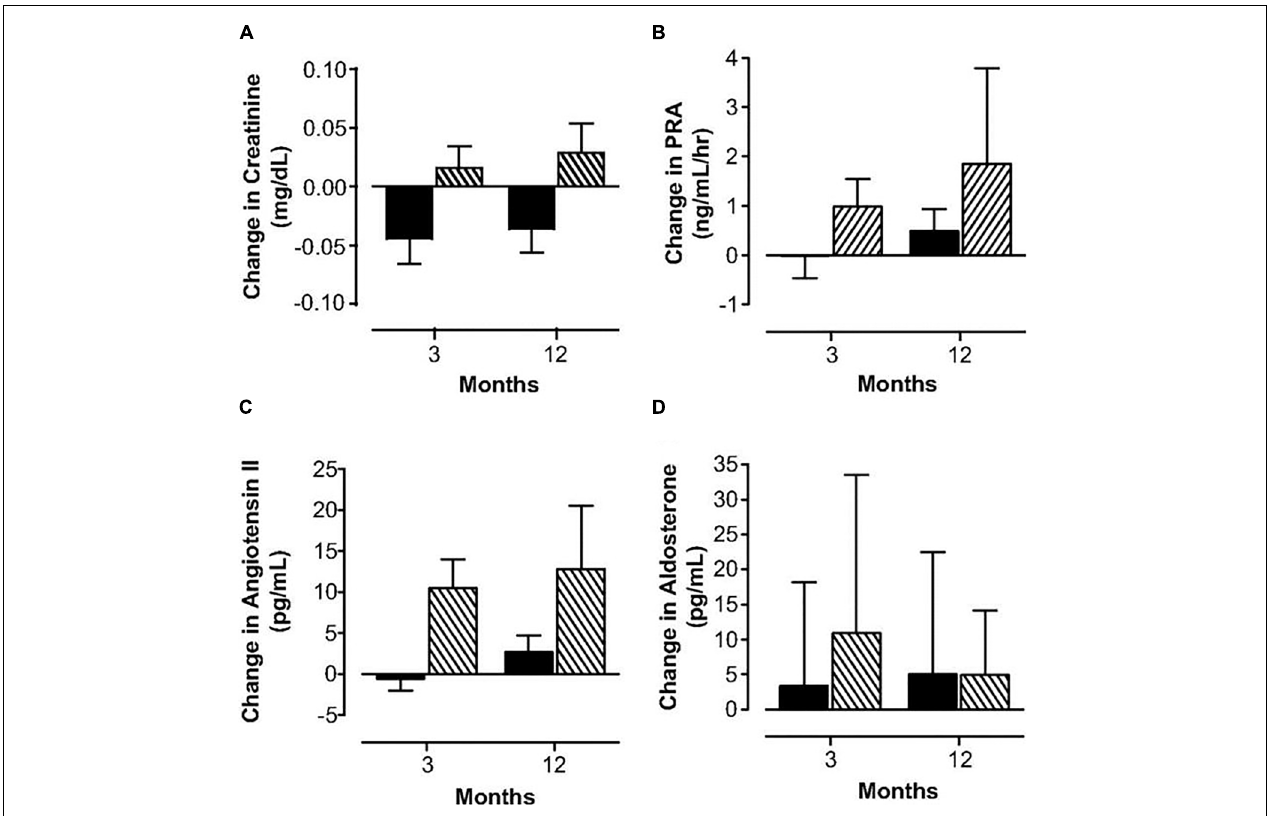
FIGURE 3 | Changes in serum creatinine (A) , plasma renin activity (B) , angiotensin II (C) and aldosterone (D) concentrations in women with POI treated with physiologic HRT ( (cid:4) ) or standard OCPs ( (cid:3) ). Langrish et al.